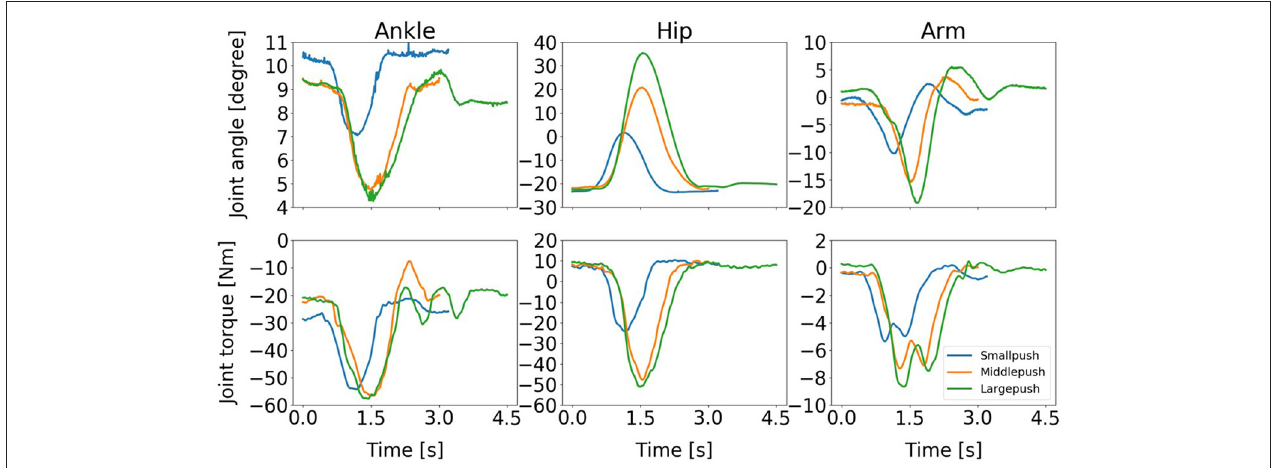
FIGURE 14 | Evolution of the joint angles and torques of the ankle, hip, and arm for three different magnitudes of push: (1) Small push, (2) Medium push, and (3) Large push. It is important to note that ankle joint angle and torque don’t change from middle push to large push. It implies necessity of arm usage after ankle usage